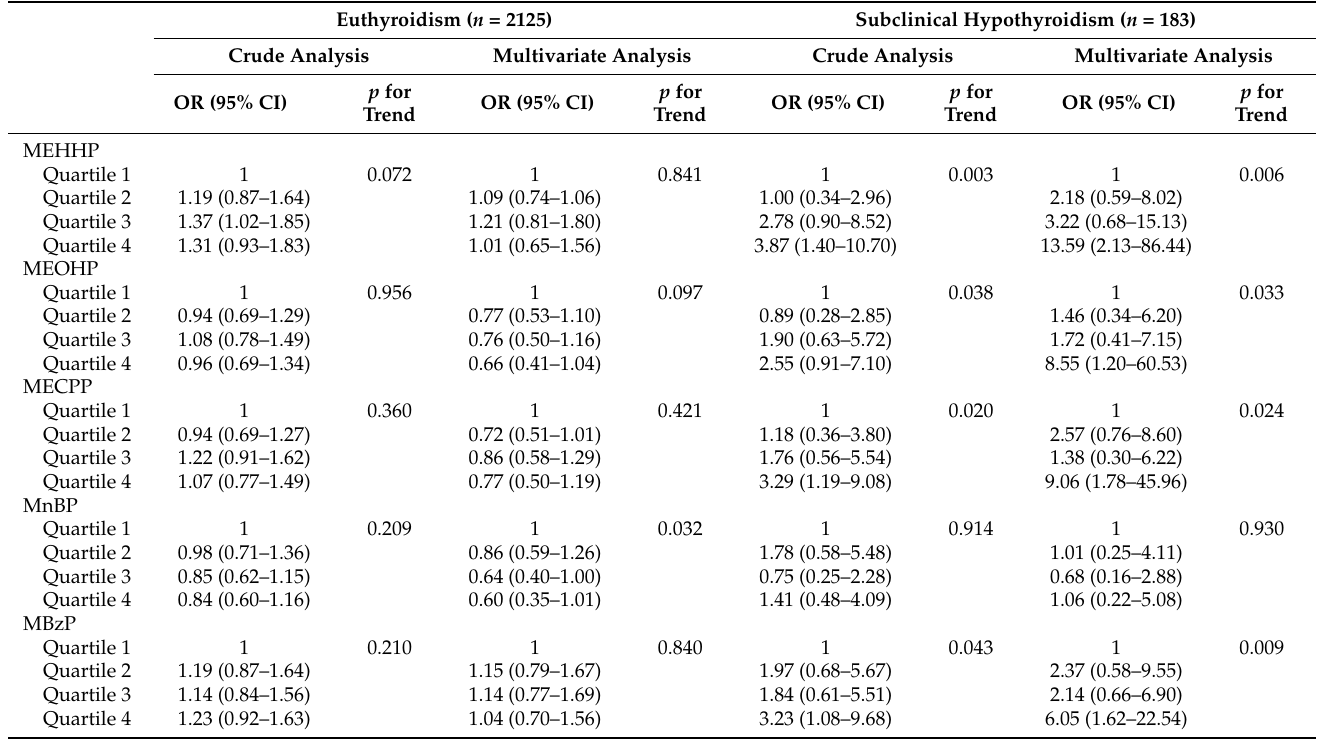
Table 5. The association between urinary phthalate metabolites and NAFLD after being classified into participants with euthyroidism and with